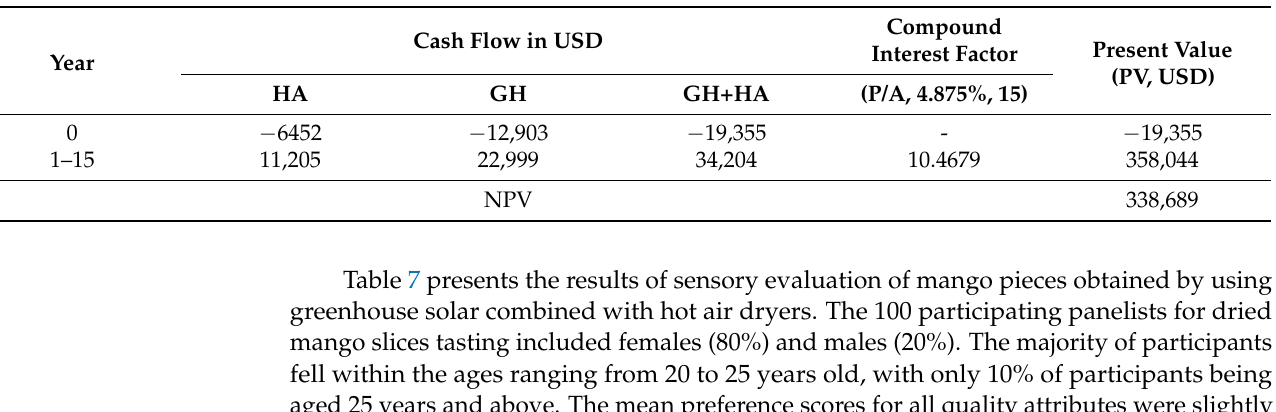
Table 6. Net present value analysis of dried mango slices using a combination of greenhouse solar and hot air